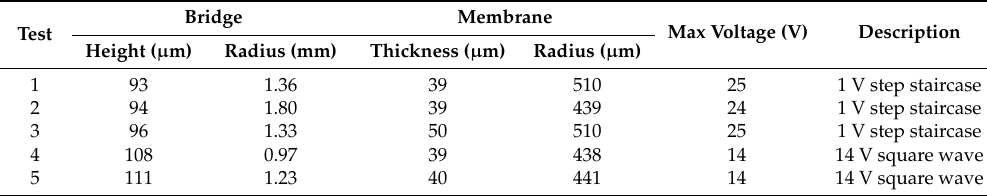
Table 1. Dimensions and descriptions for the single-active-surface tests